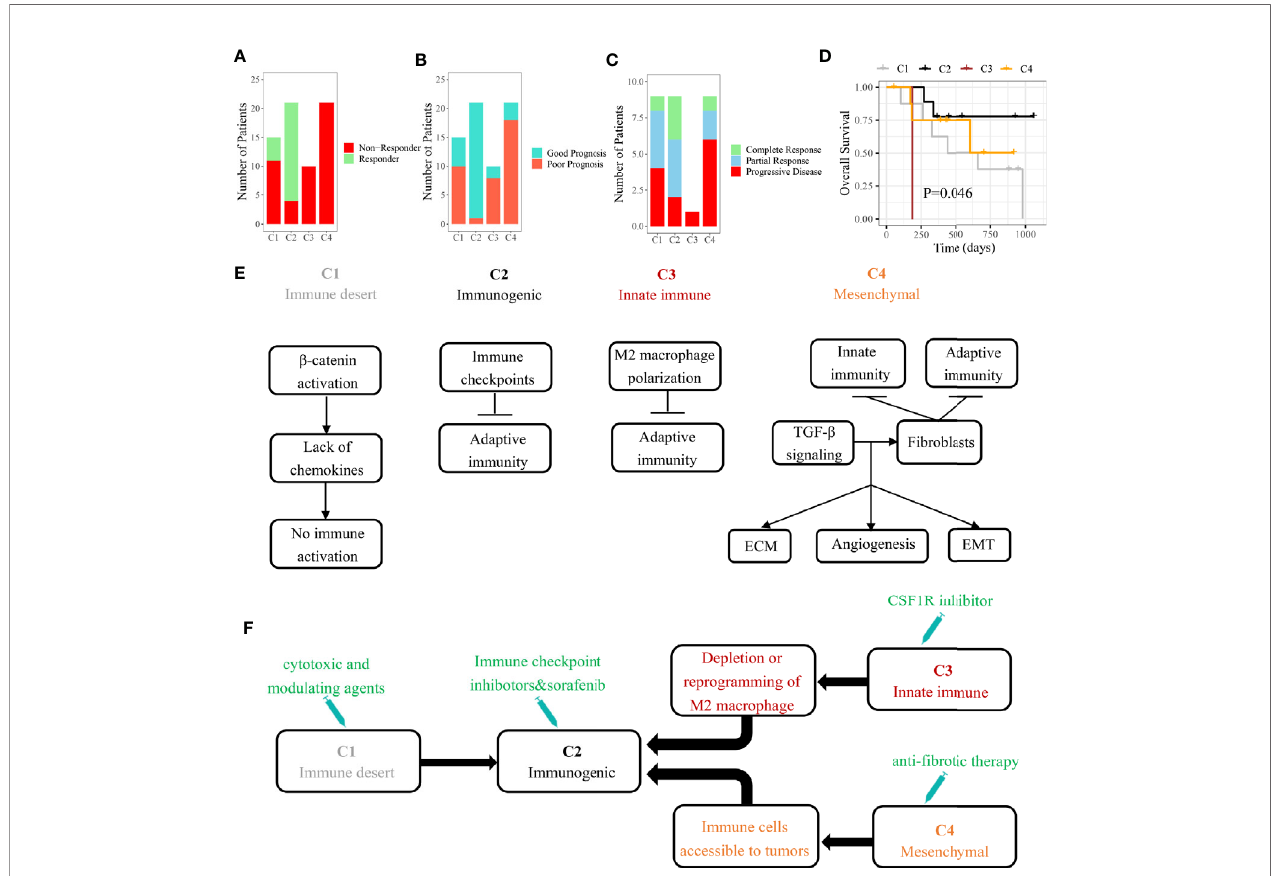
FIGURE 6 | The role of immune subclass in personalized treatment and schematic summary of each immune subclass. (A) The number of patients with response to sorafenib. (B) The number of patients belonged to good or poor prognosis subgroup. (C) The number of patients with response to anti-PD-1 therapy. (D) Kaplan- Meier curves of overall survival for GSE78220 cohort (log-rank test, P = 0.046). (E) The mechanisms of immune escape for each immune subclass. (F) Potential therapeutic strategies for each immune